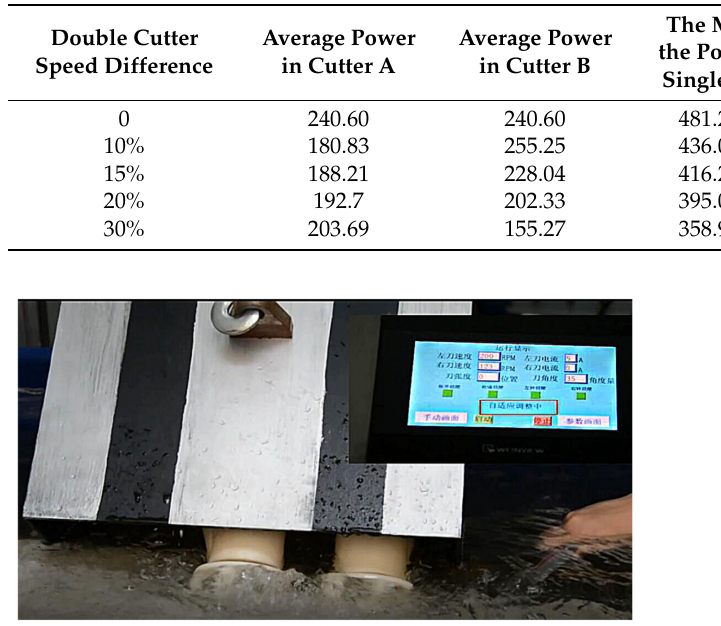
Table 5. Average power meter of different rotational speed difference of a new type of cutter dredger.